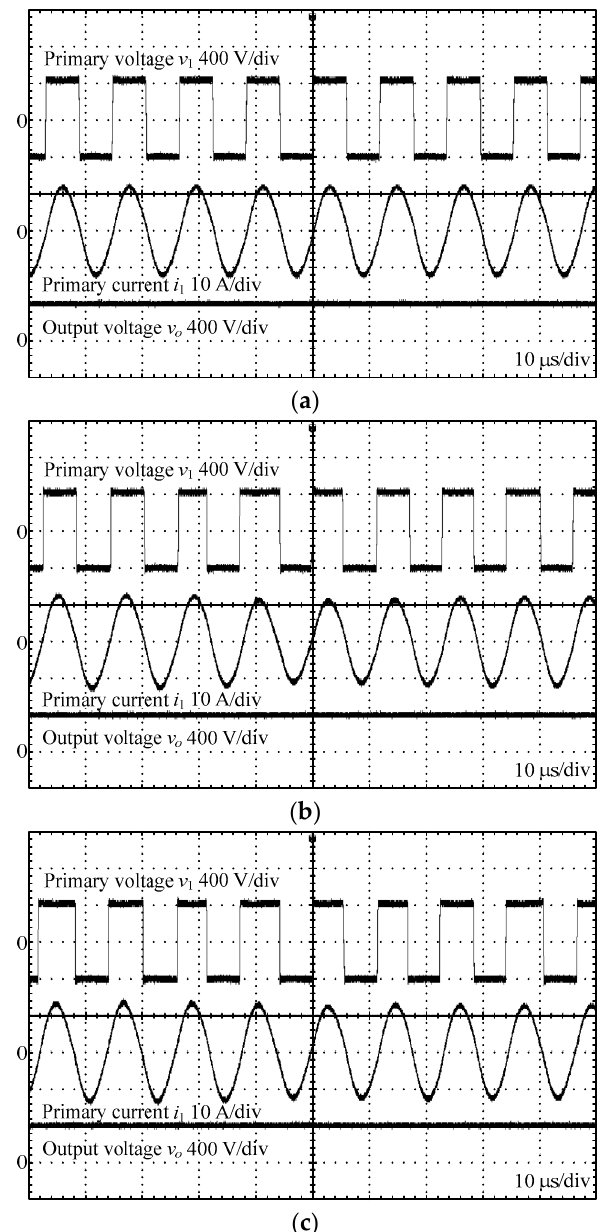
Figure 8. Operation waveforms with SP compensation: ( a ) is the constant frequency operation, ( b ) is the SSUD, and ( c ) is the SSBD.